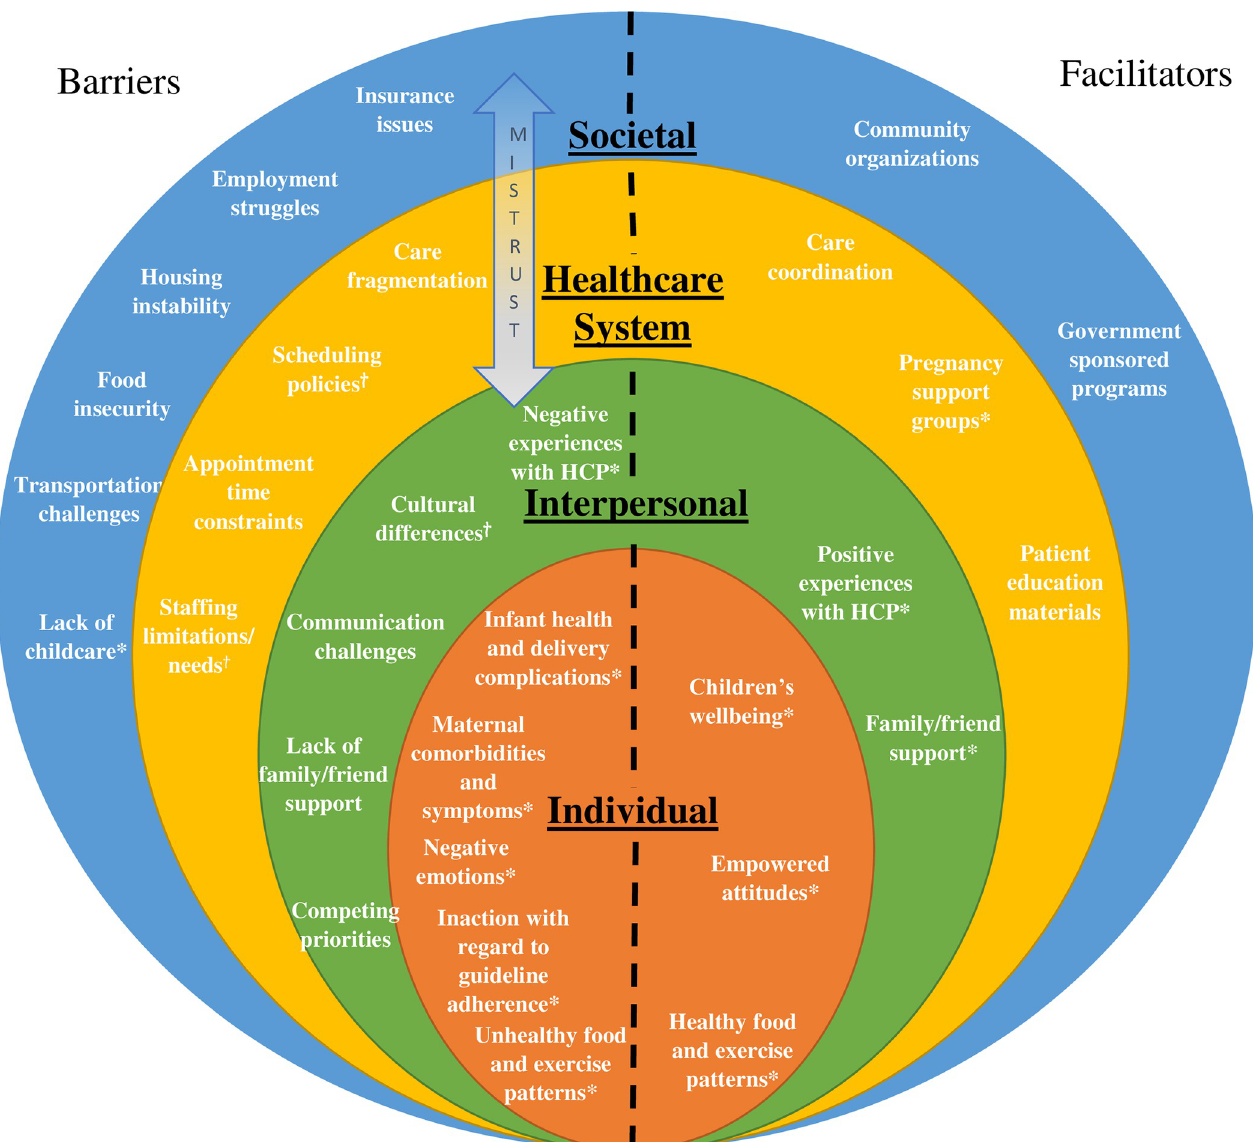
Fig 1. Socioecological model adaptation with barriers and facilitators to T2DM screening and prevention identified by patients and HCP. No symbol: mentioned by HCP and patients. � mentioned by patients only. ⴕ mentioned by HCP only.